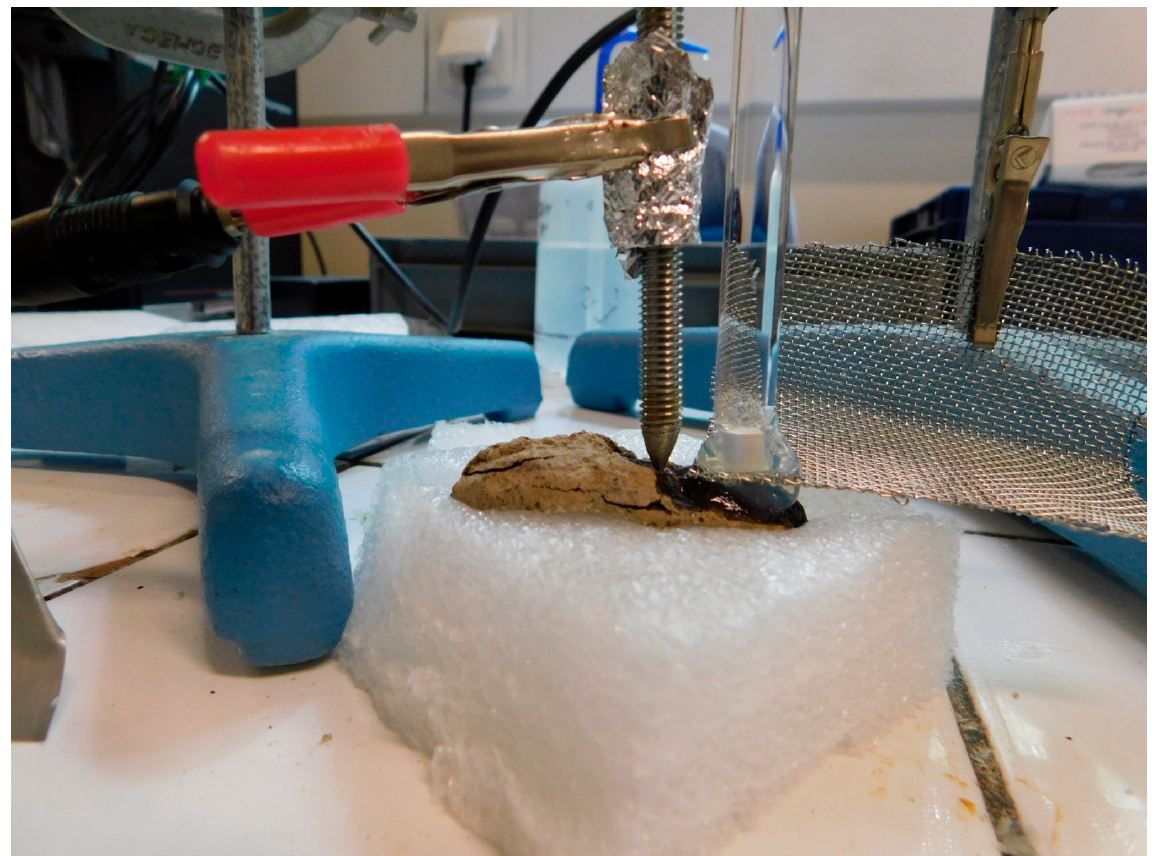
Figure 8. The electrolytic assembly for the stabilization using gel of an archaeological iron object (© C. Fontaine/Arc’Antique—Grand Patrimoine de Loire Atlantique, Nantes, France).